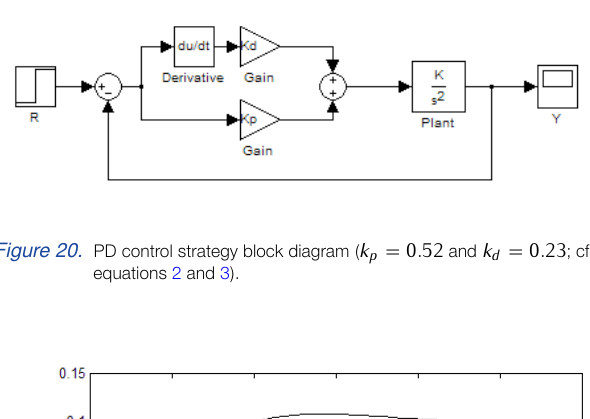
Figure 22. Discrete control strategy block diagram that is equivalent to the continuous-time design obtained earlier.